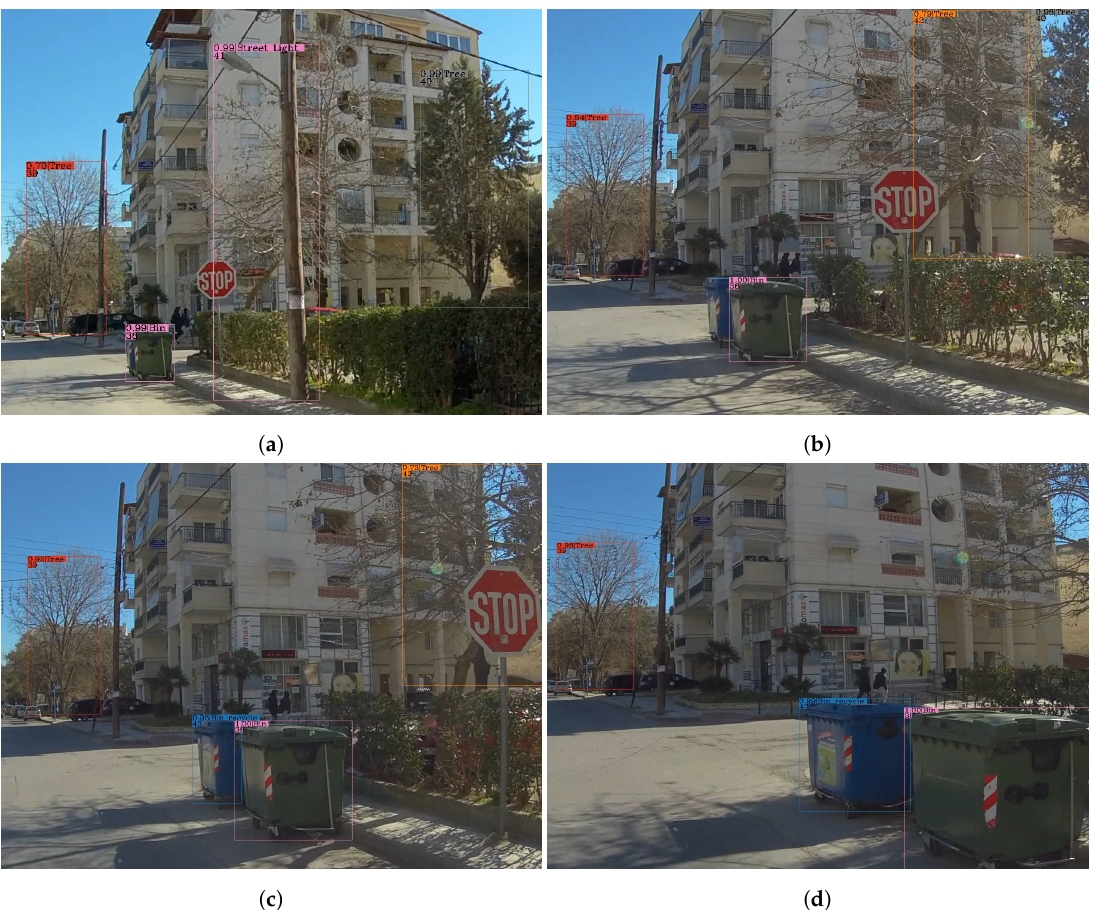
Figure 6. Example of object tracking in consecutive frames with the ByteTrack method [41]. ( a ) First frame. ( b ) Second frame. ( c ) Third frame. ( d ) Fourth frame.